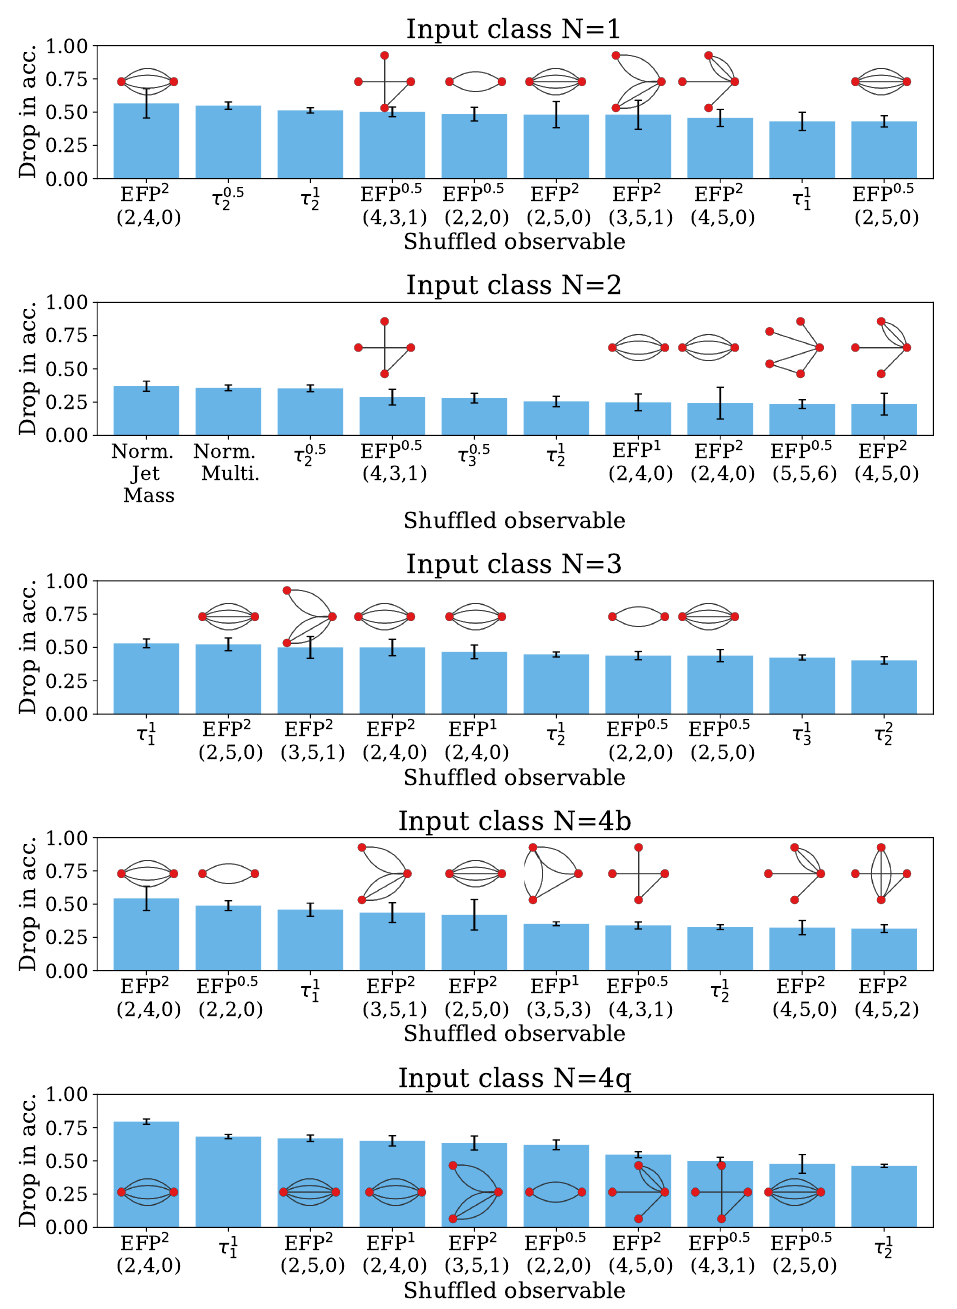
Figure 15 . Accuracy drop and statistical uncertainty of the top 10 observables per input class N = 1 , 2 , 3 , 4 b, 4 q . The observables are ranked in order of importance, where the most important are those resulting in the largest drops in accuracy of the model when randomly replaced with observable values from the training set. The EFP graphs are included for visualization